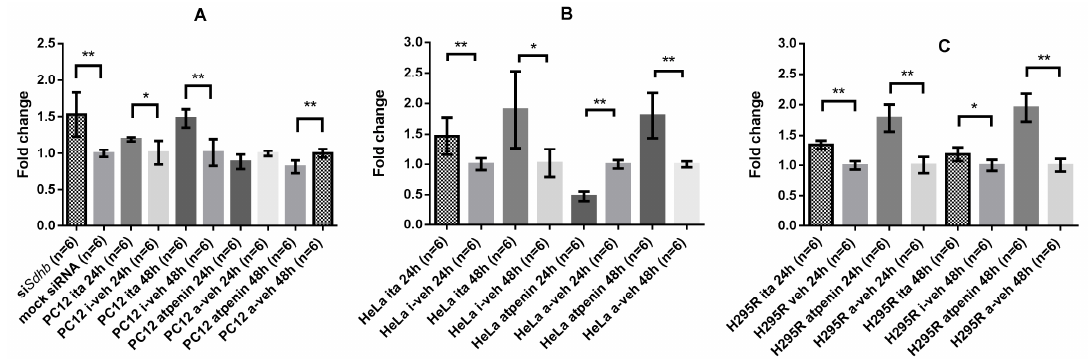
Figure 5. Glutaminase-1 (GLS-1) expression of PC12 and HeLa cells upon SDH inhibition: all values are normalized to control. ( A ) Fold changes in GLS-1 expression in PC12 cells upon Sdhb knockdown, itaconate treatment, and atpenin treatment. ( B ) Fold changes in GLS-1 expression in HeLa cells upon itaconate and atpenin treatment. ( C ) Fold changes in GLS-1 expression in H295R cells upon itaconate and atpenin treatment. Ita: itaconate; i-veh: control for itaconate experiments; a-veh: control for atpenin experiments; *: p < 0.05; **: p < 0.01.